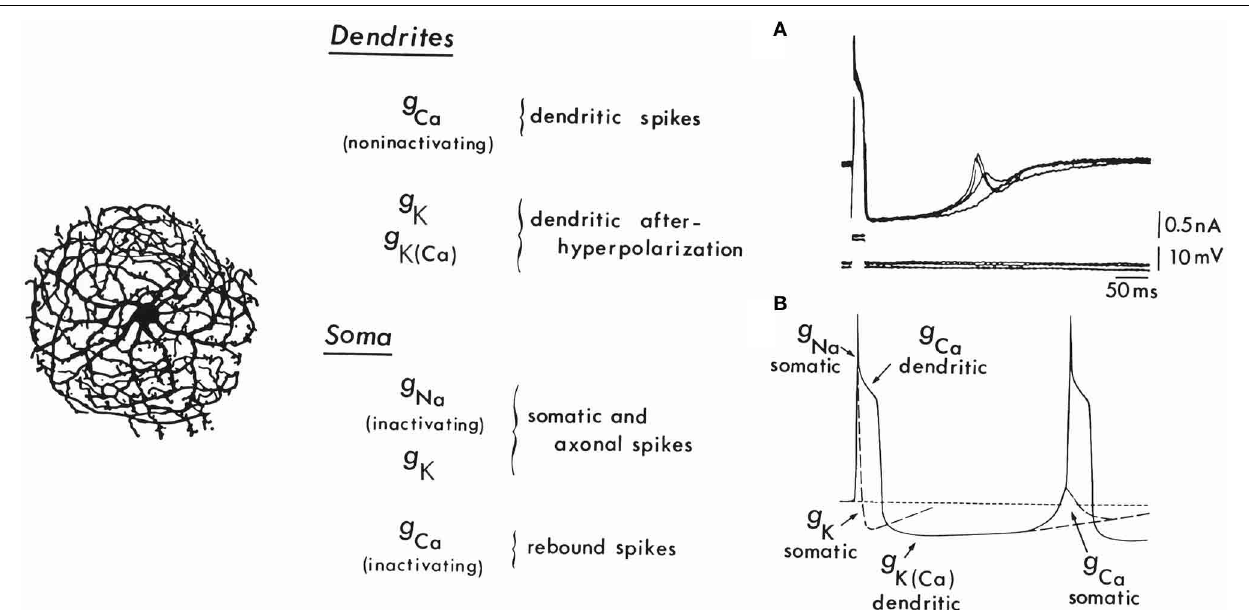
FIGURE 5 | Ionic conductances and the mechanism for oscillation in inferior olivary cells. Left: Drawing of an inferior olivary cell by Ramón y Cajal. Center: Table giving the distribution of ionic conductances in somatic and dendritic regions. At the soma a set of conductances (g Na and g k ) generating fast action potentials may be observed. In addition, a strongly inactivated Ca 2 + conductance is present, which produces rebound spikes, as seen in (B) [g Ca(somatic) ]. Also recorded at the soma is a large Ca 2 + -dependent